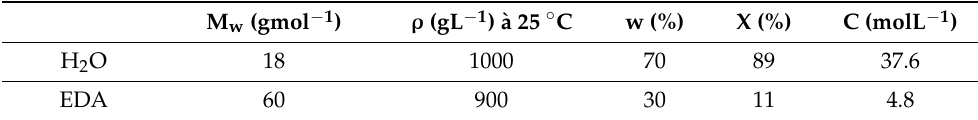
Table 1. Composition of the